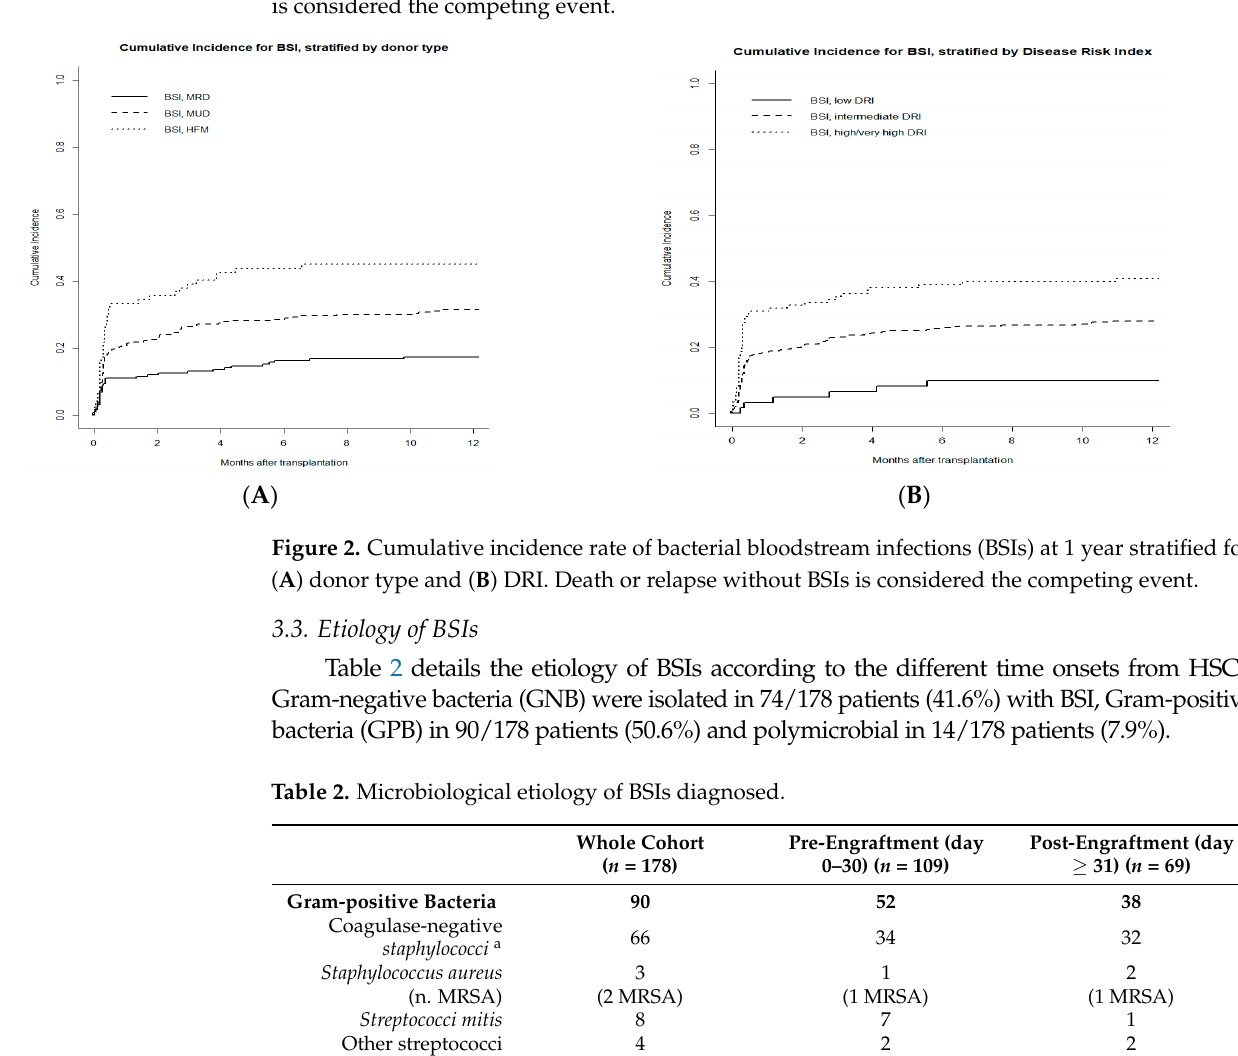
Figure 1. The cumulative incidence rate of bacterial bloodstream infections (BSIs) is 19.4%, 23.8%, and 28.7% at 1, 3 and, 12 months after transplant for the whole cohort. Death or relapse without BSIs is considered the competing event.